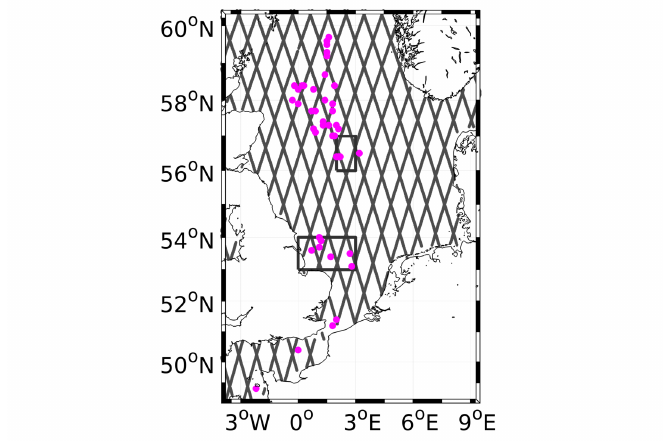
Figure 2. Locations of the in situ measurements (magenta dots) and the satellite measurements (grey tracks). The southerly box indicates the area of the in situ measurements used for the comparisons in Section 3. The northerly box indicated the area of the Hovmöller diagrams in Section